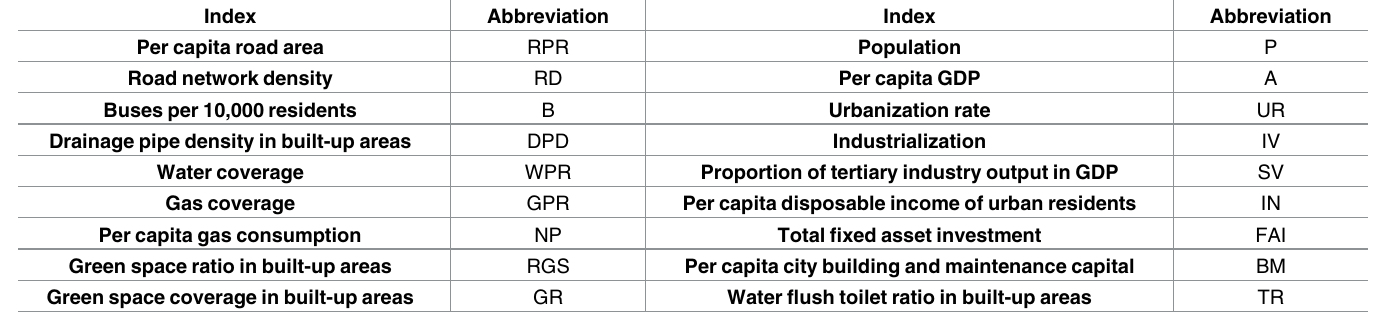
Table 1. Indexes and